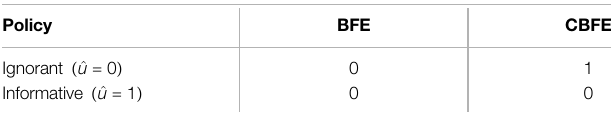
TABLE 3 | Free energies (in bits) per policy for the example